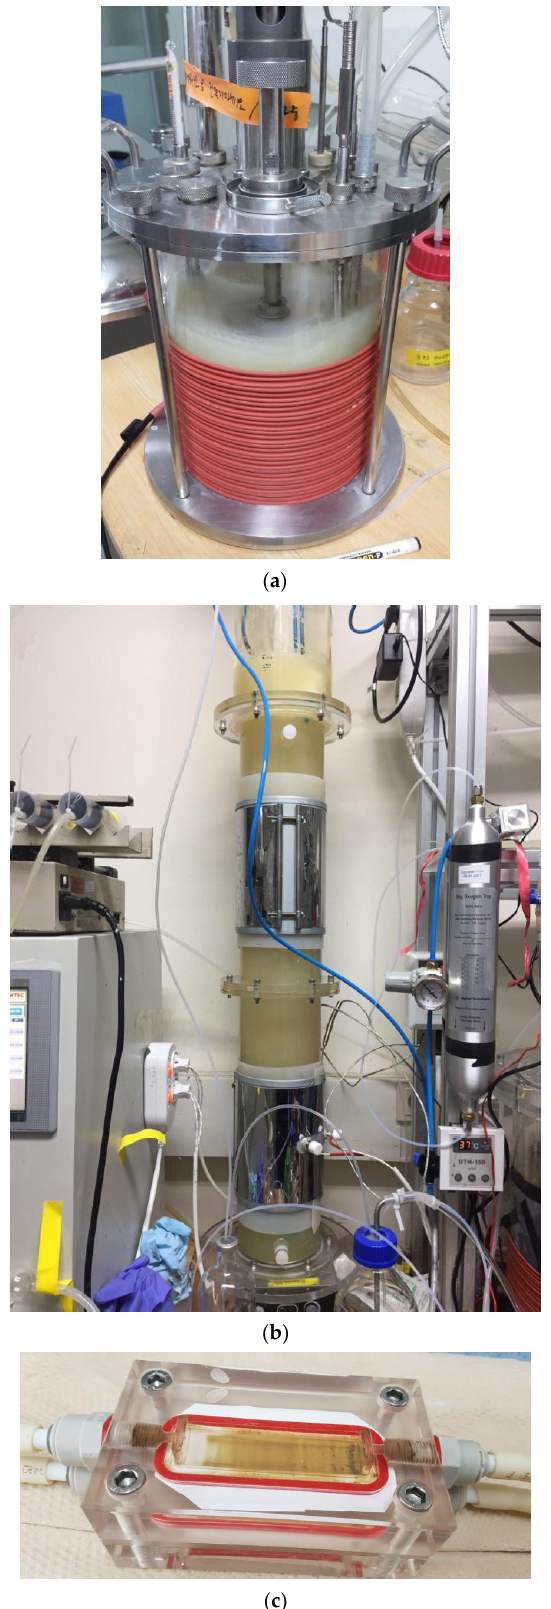
Figure 2. Images of the stirred-tank reactor (ST) ( a ), the bubble column reactor (BC) ( b ), and the membrane distillation (MD) module ( c ).